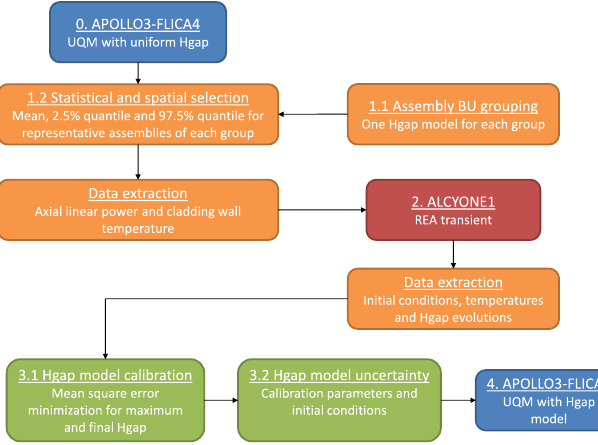
Fig. 7. High to Low H gap modeling methodology